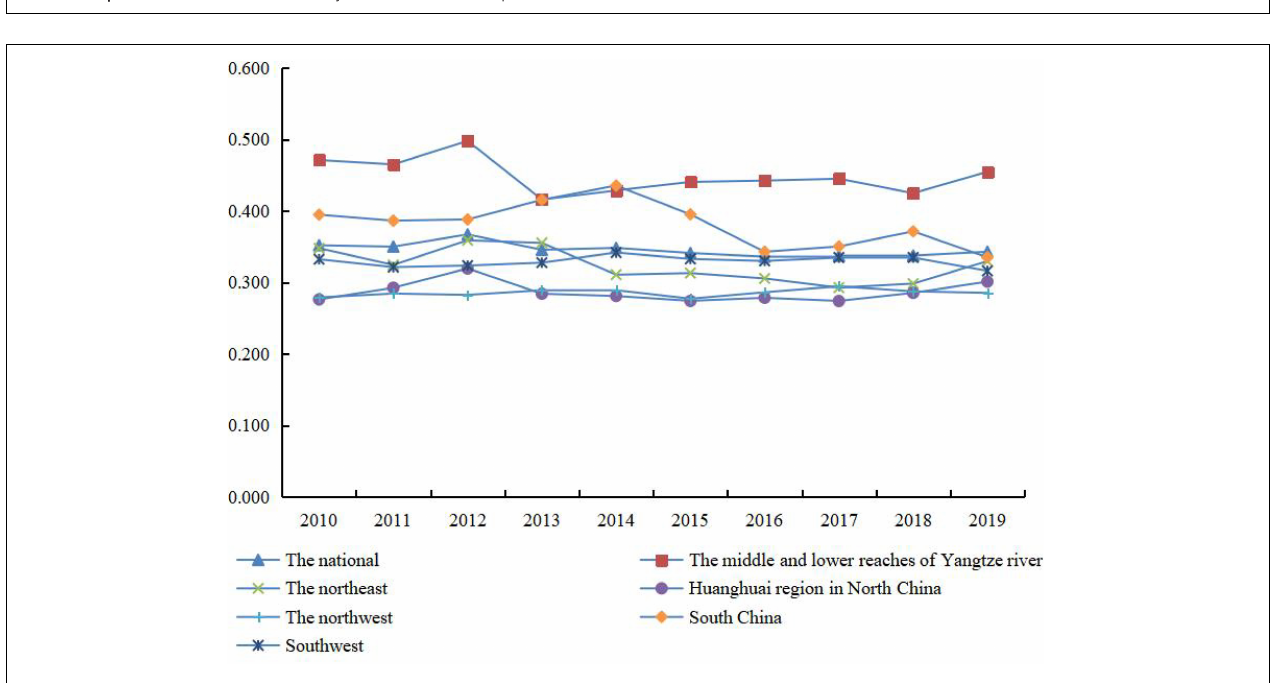
FIGURE 1 | Mean and median vulnerability to flood disasters of provincial inland fisheries from 2010 to 2019.